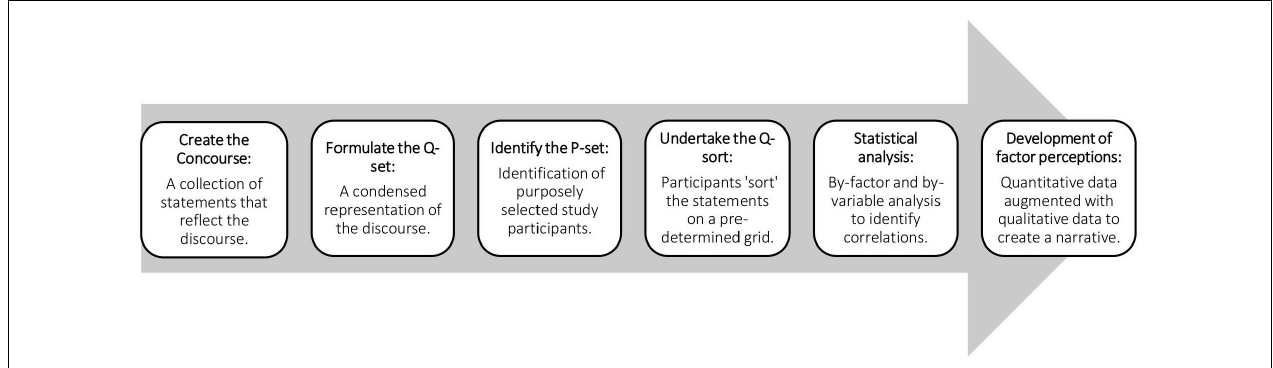
FIGURE 1 | The basic stages of a Q-methodology study: As described by Watts and Stenner (2012), Q-methodology studies start with the creation of the ‘concourse’, followed by formulation of the Q-set, identification of the P-set, the Q-sort, and statistical analysis and factor perception development.